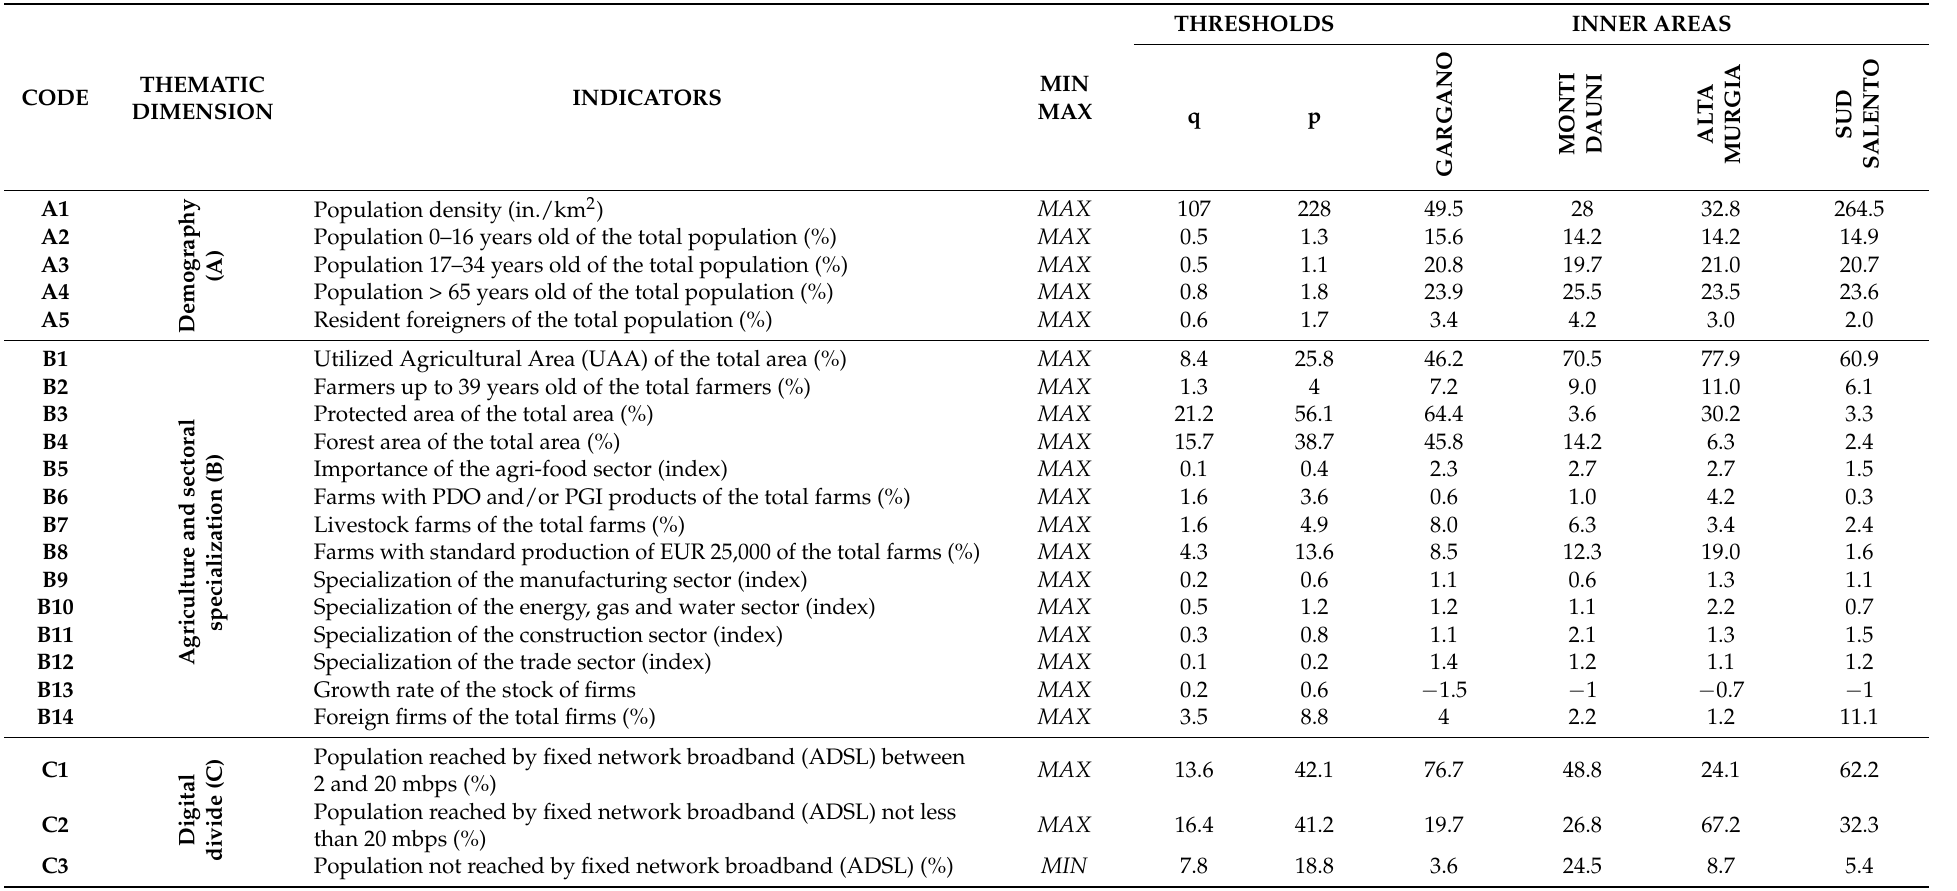
Table A1. The list of indicators with collected data and PROMETHEE II